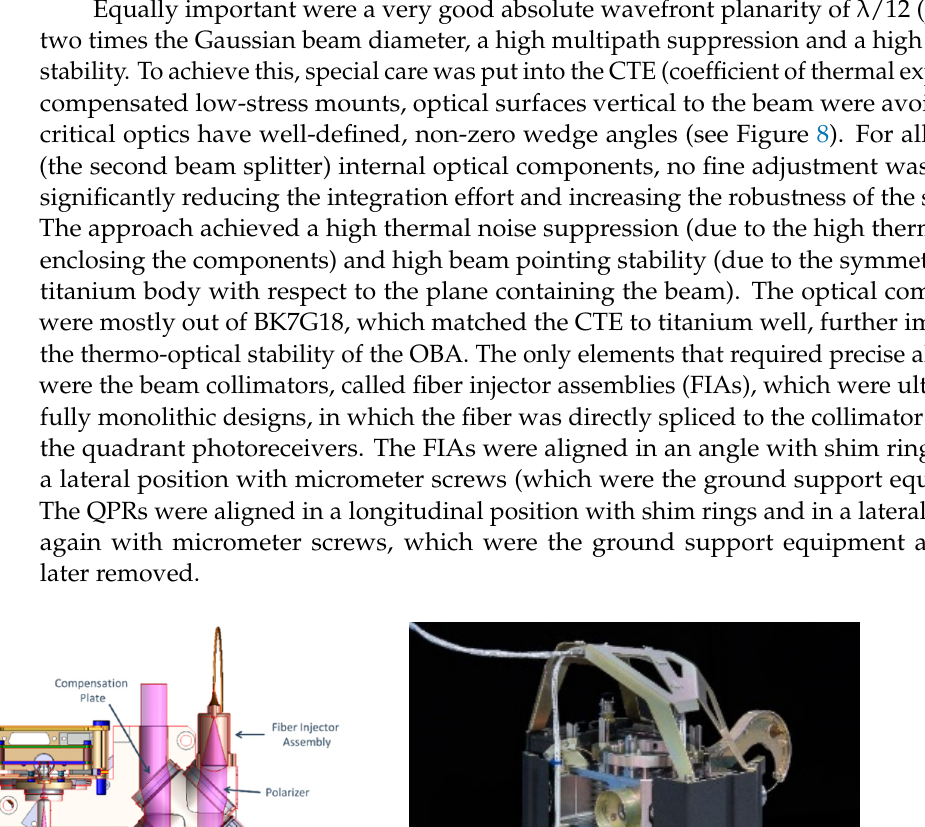
( b ) Figure 9. Optical bench concept for NGGM. ( a ) Cross-sectional view of the optical bench; ( b ) CAD picture of optical bench body with attached collimators, steering mirror and quadrant photoreceivers. The optical bench for the NGGM LTI was based on the design developed for the GRACE-FO LRI, which has been successfully operating in orbit for more than 4 years by now. The heritage of the design was considered high, and the focus on the current development activities lay on the redundant FIAs and the verification of the suitability of the updated mechanical interface. 3.5. Retroreflector Unit (RRU) The retroreflector unit consisted of an off-axis three-mirror retroreflector with its vertex located in the satellite center of mass. It routed the transmitted beam from the optical bench to the other spacecraft. Placing the vertex of each RRU at the satellite CoM enabled the LTI to measure the distance variation of the CoM of the two satellites to a